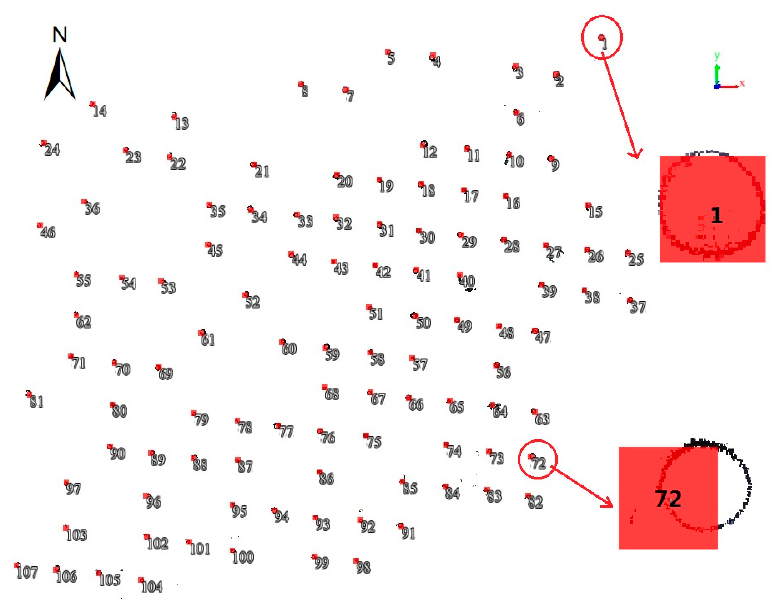
Figure 6. The localization of individual trees. The authors used the grid size of 0.2 m × 0.2 m to automatically identify and mark the center localization of the grid.